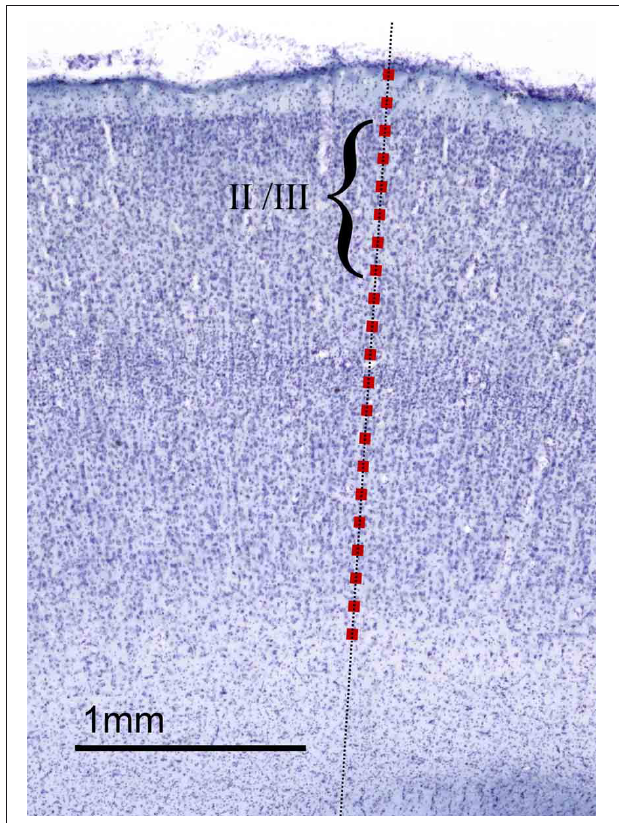
FIGURE 8 | Counting boxes for neuron density and neuron soma size estimates. As outlined in the Materials and Methods section, and as illustrated here in a section from Aotus trivirgatus temporal isocortex, sampling axes (dashed line) were placed normal to the cortex’s outer surface at chosen sites in cortical sections. Along each sampling axis, counting boxes measuring 41 μ m × 41 μ m (red squares, drawn to scale) were placed, typically at 100 μ m intervals, from the surface to the white matter. Neuron density estimates were made within each counting box. In those counting boxes that lay in cortical layers II and III (indicated by the bracket), estimates of neuron soma size were also made.